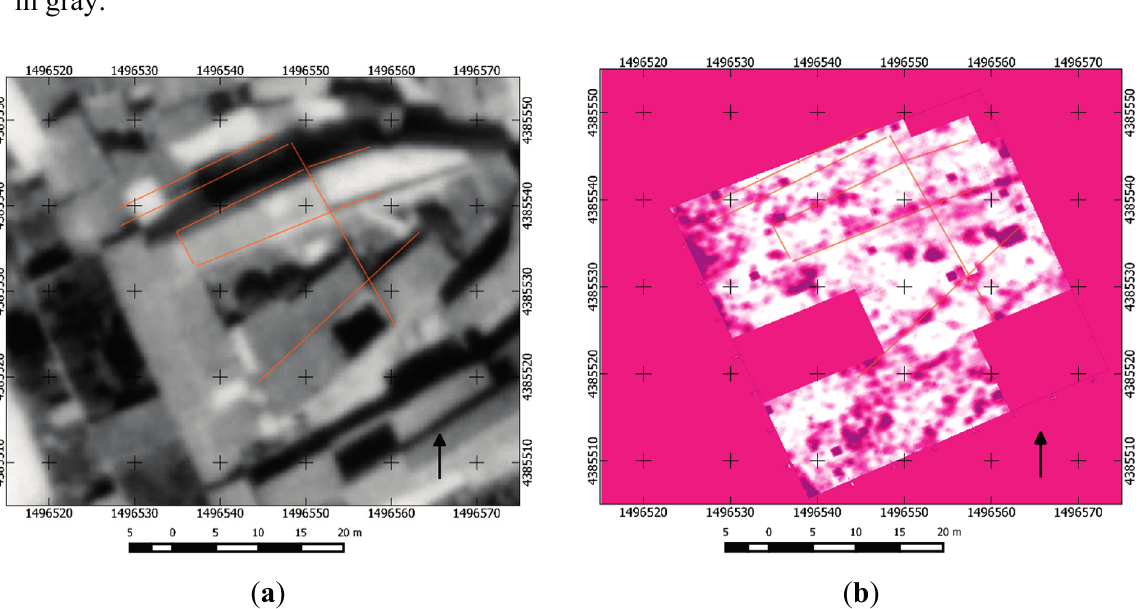
Figure 11. ( a ) The aerial photograph of 1977 with the tracking of some alignments of some of the main walls in yellow; ( b ) the GPR map at a 0.50-m depth with tracking of alignments in